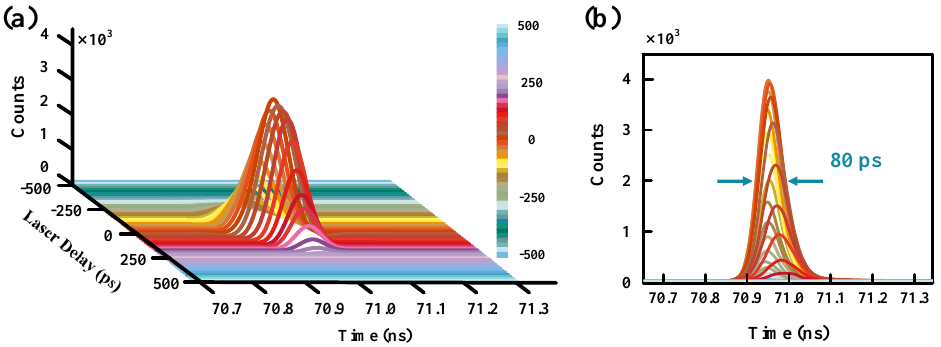
Figure 6. ( a ) Time distributions of the SPAD’s counts as a function of the delay between S SYN and S laser . ( b ) Accumulation time distributions with different S laser delay.